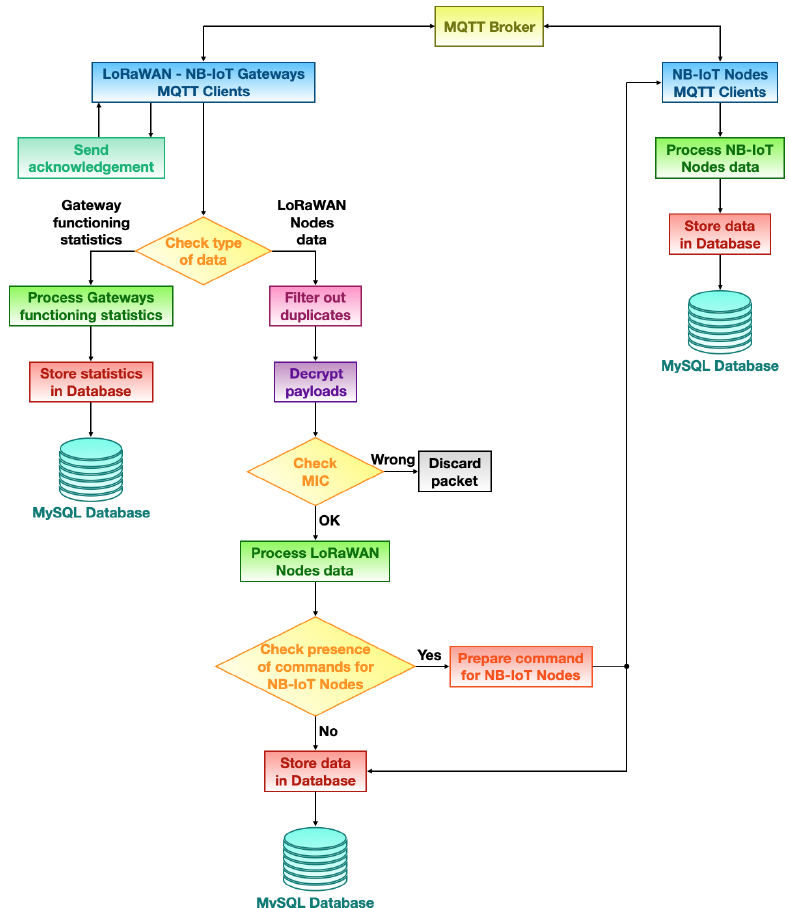
Figure 6. Network Server block scheme. The MQTT broker is included for the sake of